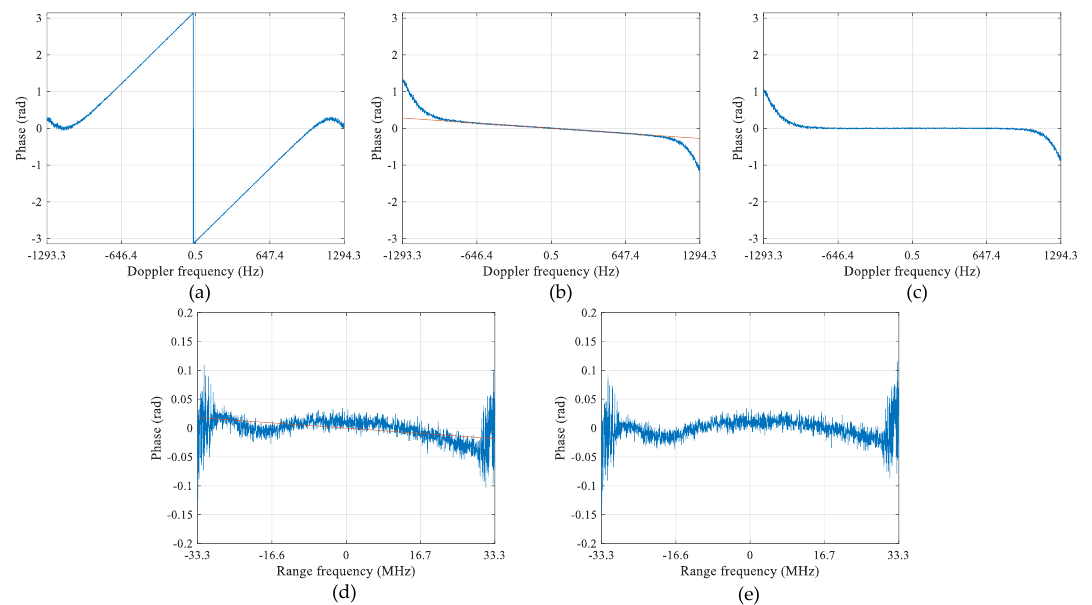
Figure 5. Interferometric phase in Doppler domain ( a – c ); and interferometric phase in range frequency domain after along-track co-registration ( d , e ): ( a ) before co-registration; ( b ) after coarse along-track baseline co-registration; ( c ) after residual along-track baseline co-registration; ( d ) phase in range frequency domain after along-track co-registration; and ( e ) after across-track co-registration.